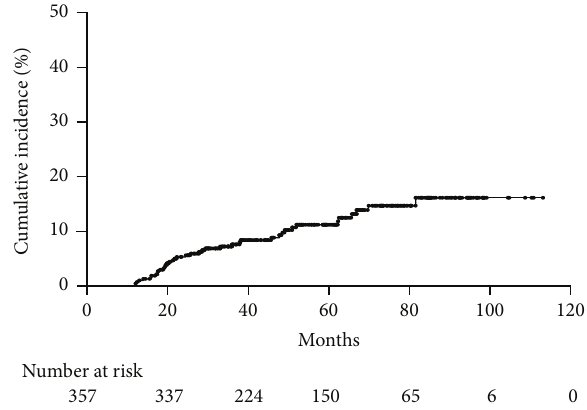
Figure 1: Kaplan-Meier curve of the cumulative incidence of metachronous tumors after ESD for gastric